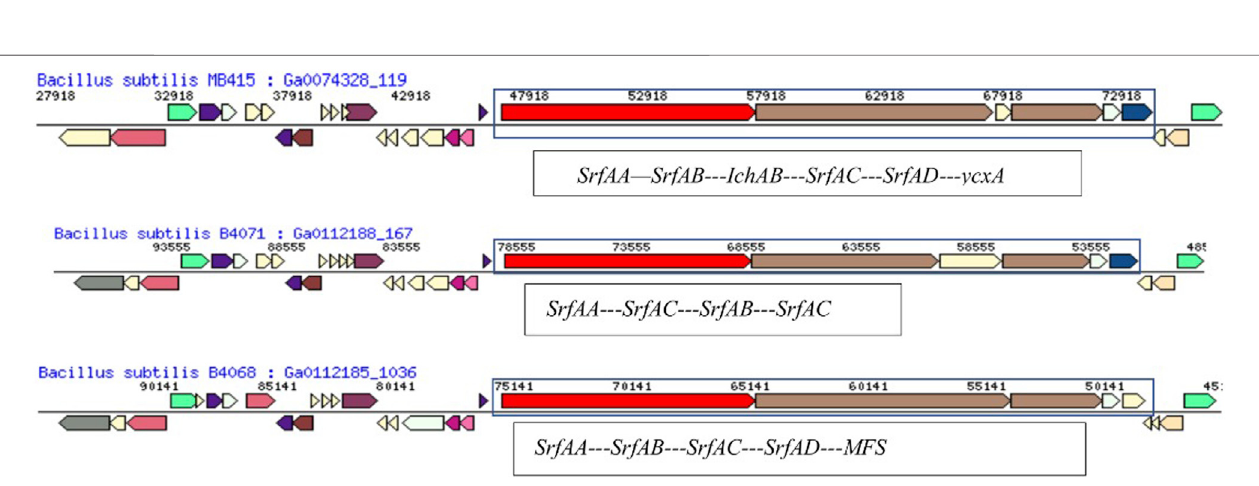
FIGURE 6 | Comparison of the hydrocarbon-degrading gene locus srf operon of Bacillus subtilis MB415 and other Bacillus species.